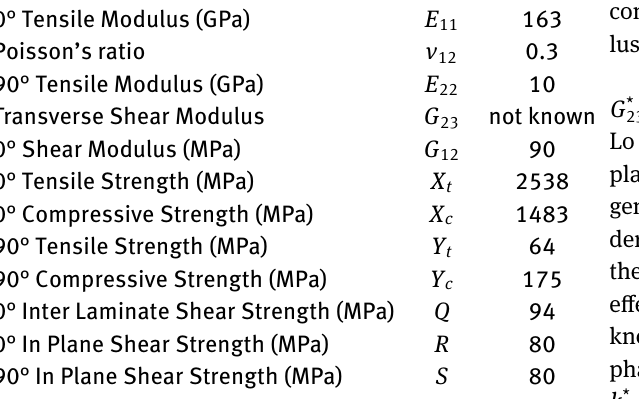
Table 1: Mechanical Properties HexPLY®